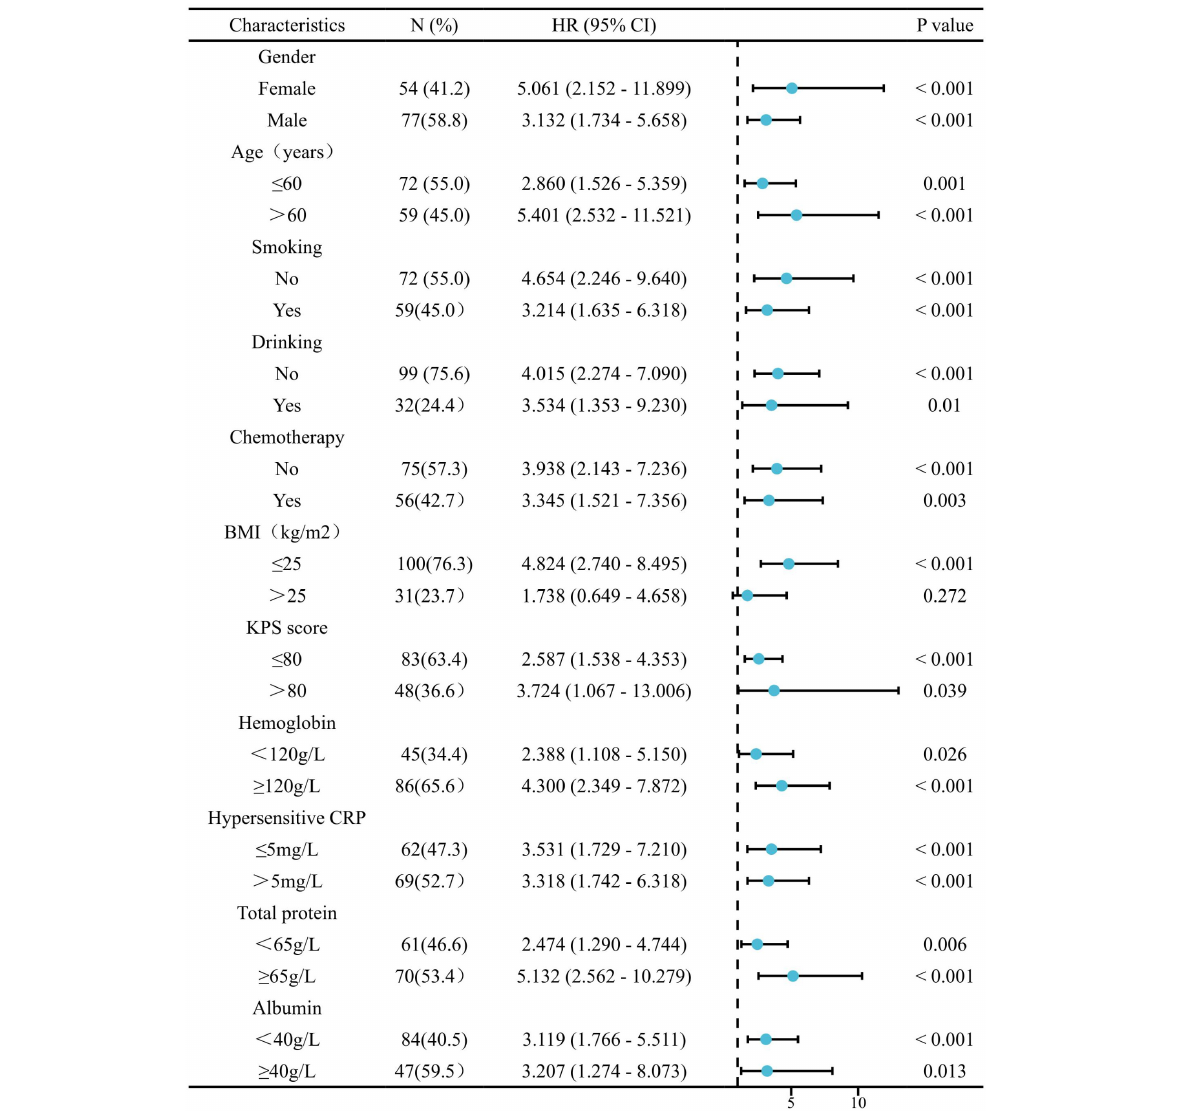
FIGURE4 The association between sarcopenia and hazard ratios of PFS in various subgroups. BMI, body mass index; KPS, Karnofsky performance status; hCRP, hypersensitive C-reactive